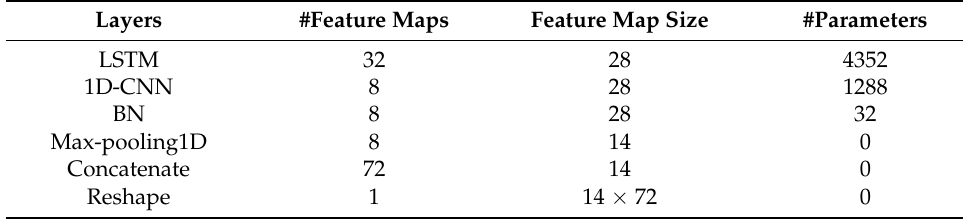
Table 2. Layer 1 construction.